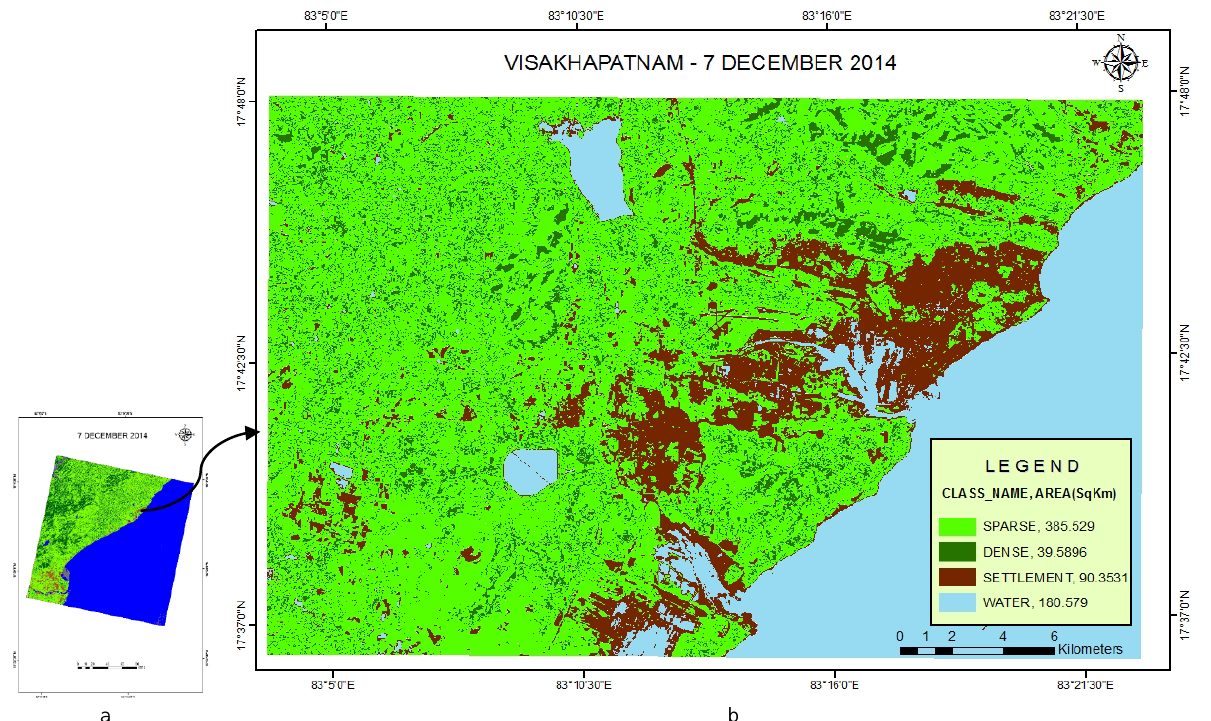
Figure 8. (a) NDVI classification map (b) Study area is clipped from the NDVI classification